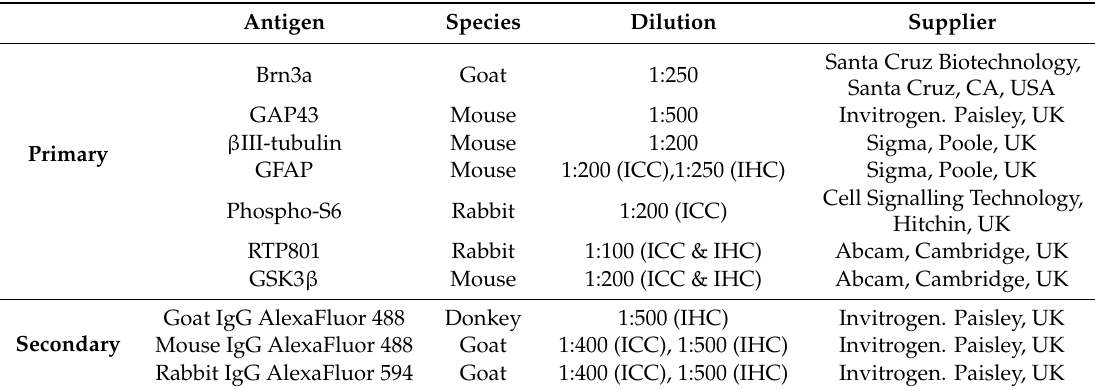
Table 1. List of primary and secondary antibodies used in this